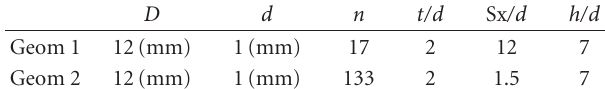
Table 3: Design code: Geometric parameter. Manifold diameter “ D ” m Manifold thickness “ t ” m Holes number “ n ” Holes spacing “Sx” m Nozzle to wall distance “ h ” Table 4: Validation of the 1D code: Analized geometries.